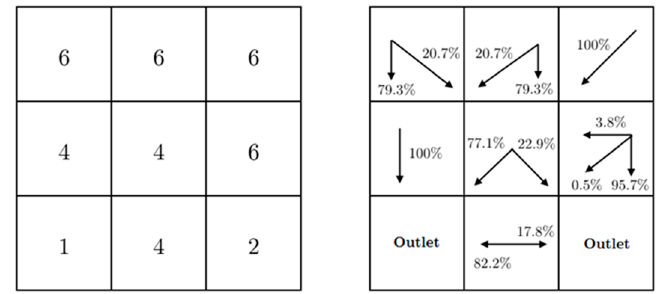
Figure 3. Calculation of flow directions in the MFD ‐ md algorithm [18].